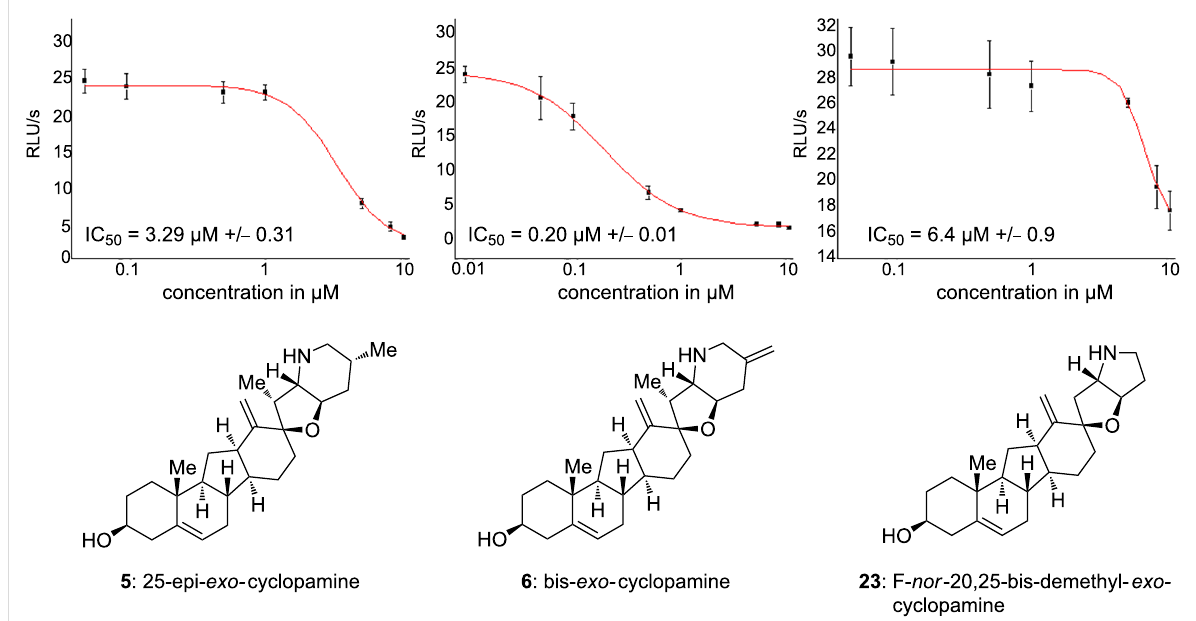
Figure 2: IC 50 values of Shh inhibition by compounds 5 , 6 and 23 in a Gli1-reporter gene assay. Data were obtained from three independent experi- ments and represent the mean ± standard deviation.